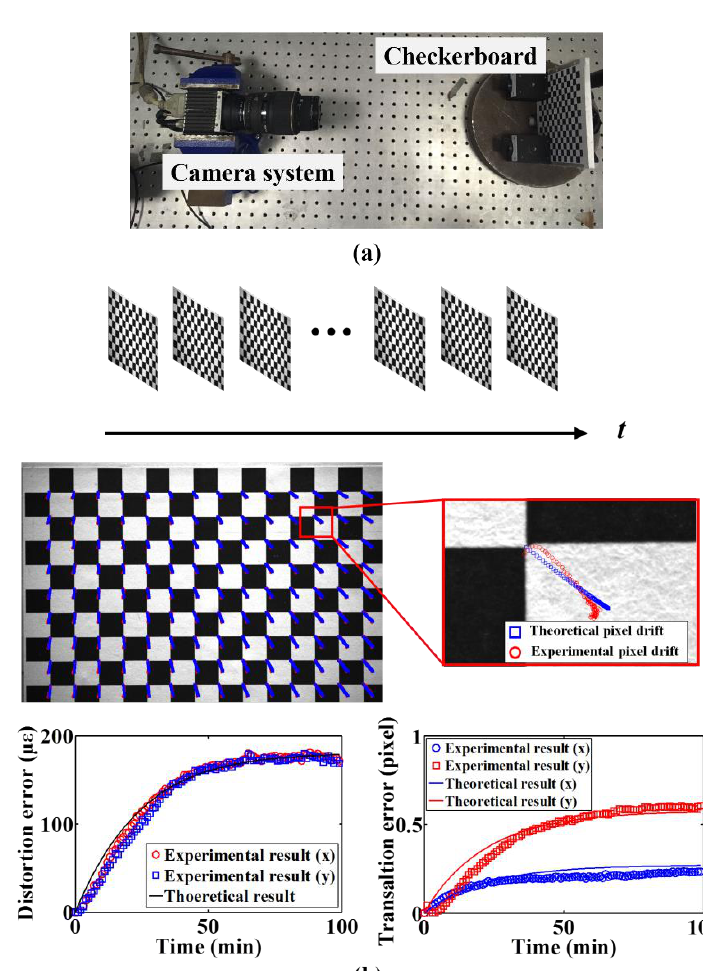
Figure 8. Experimental verification of the established image error models: ( a ) experimental arrangement